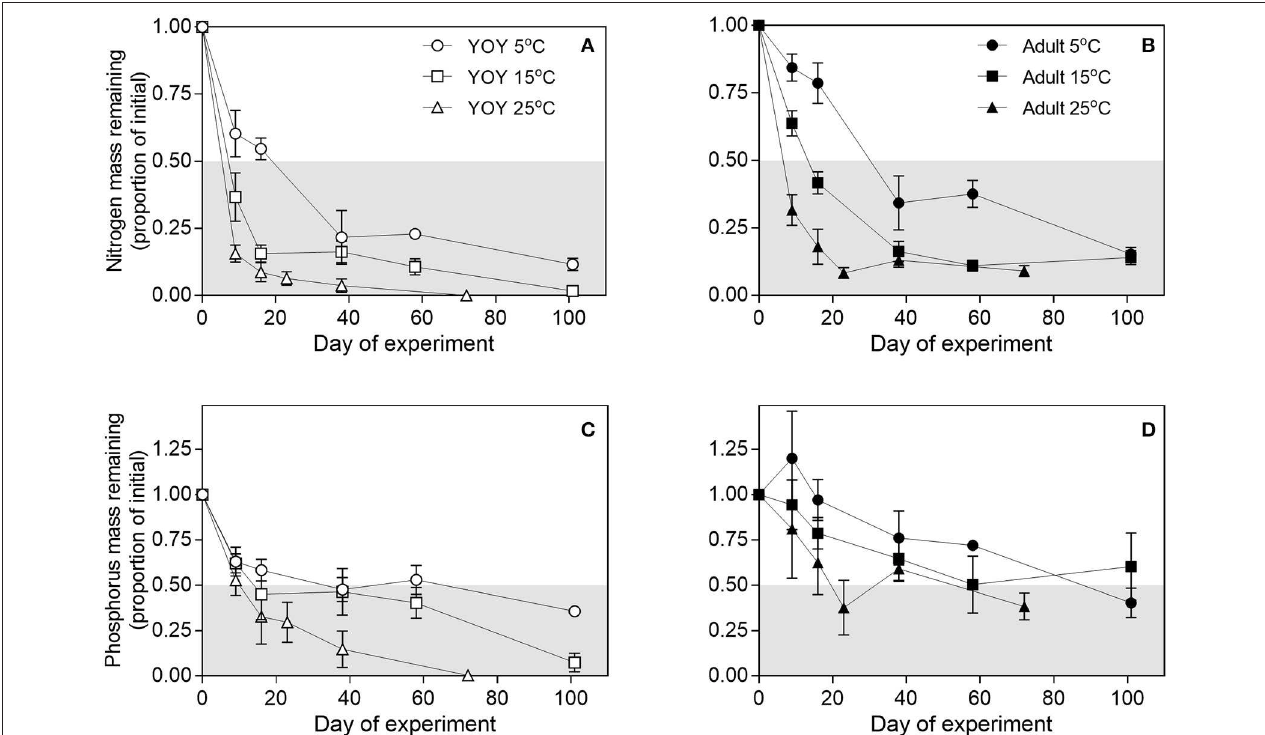
FIGURE 2 | Individual and interactive effects of fish size and temperature on patterns of mass remaining for (A,B) nitrogen (C,D) phosphorus mass in decomposing fish carcasses throughout time. Values are expressed as the proportion of initial mass in carcasses. Data for young-the-year (YOY) and adult fish are shown in separate panels for clarity. The transition between the white and gray areas in the panels indicate the half-lives of mass decay. Data points are mean ( n = 3) and error bars are ± 1SEM.